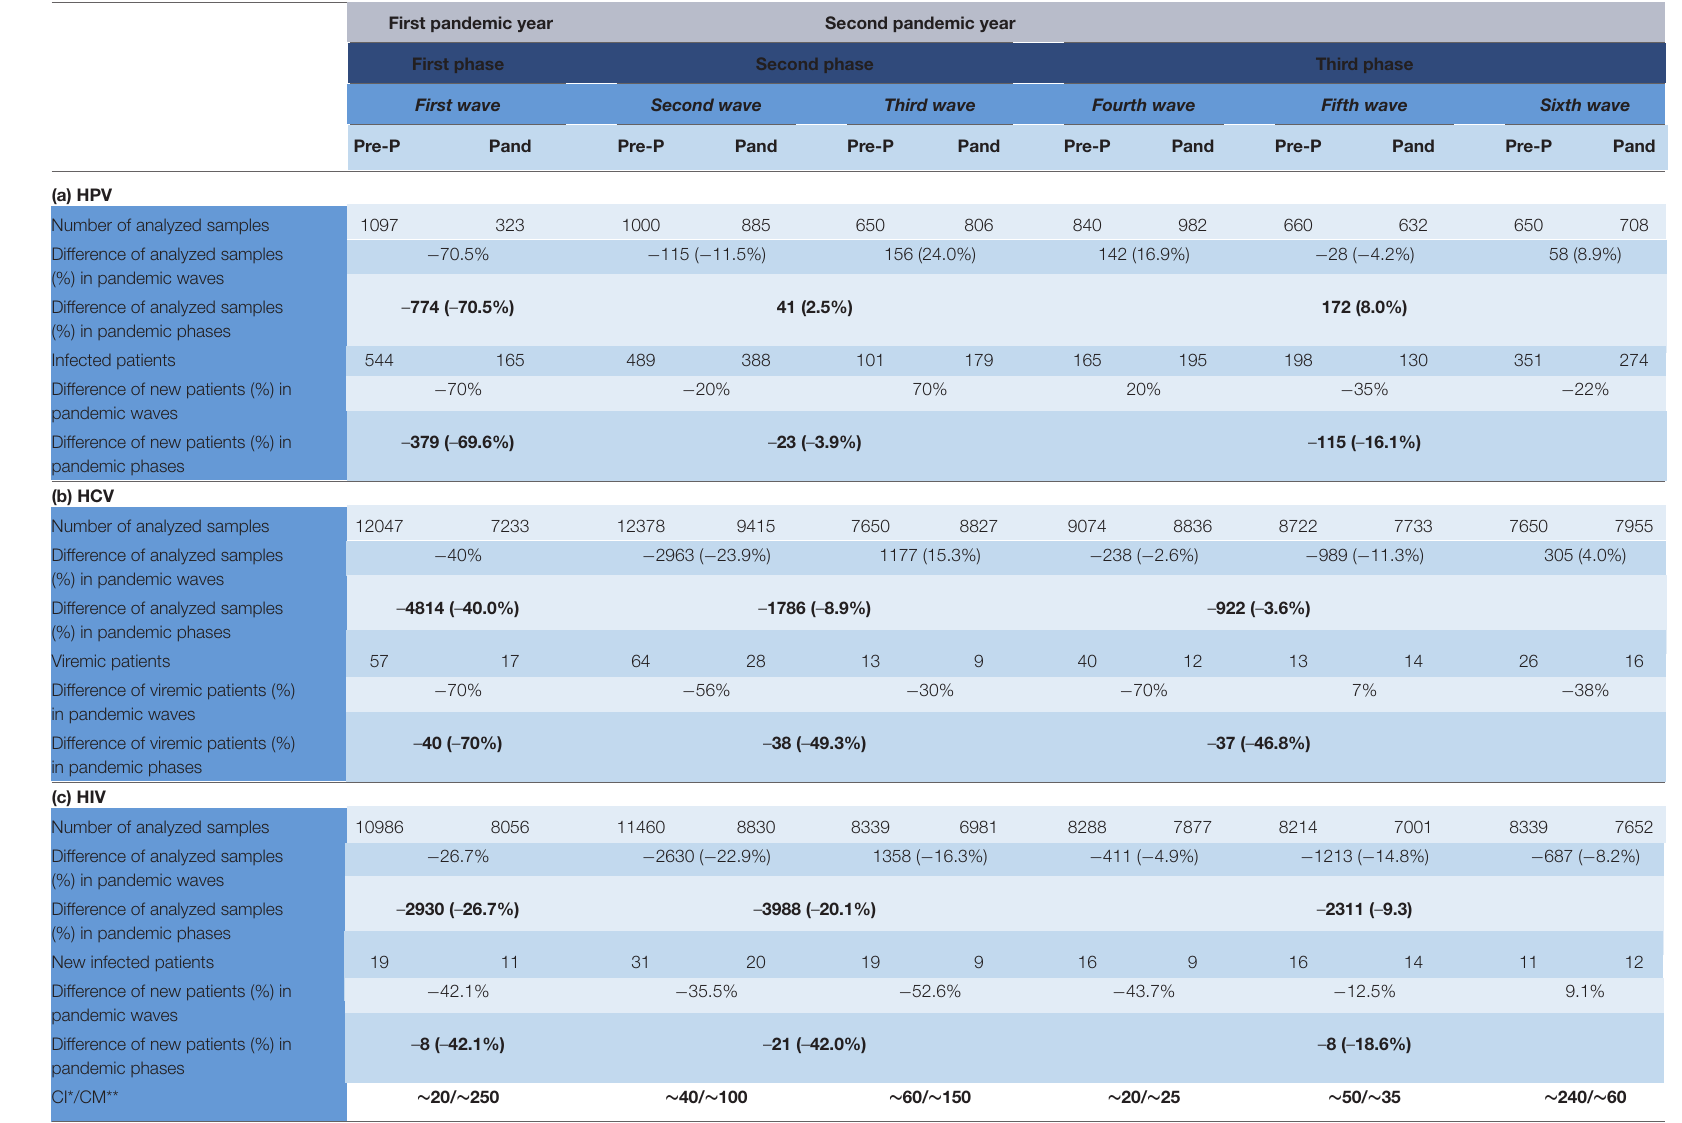
TABLE 1 | HPV (a), HCV (b) and HIV (c) determinations in pre-pandemic and pandemic period during the different pandemic